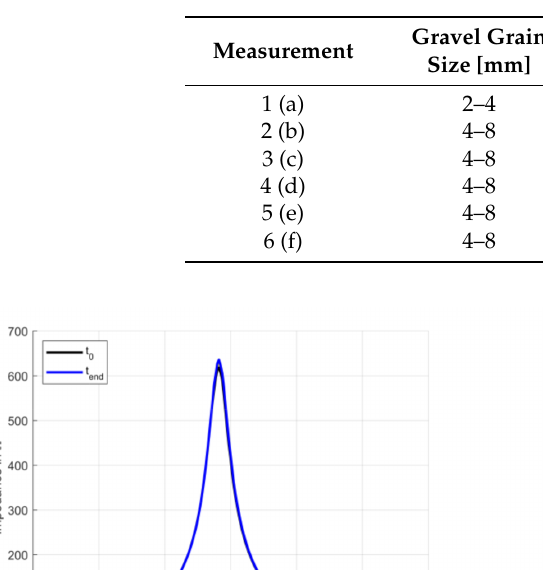
Table 2. Input parameters (gravel grain size, hydraulic gradient) and results (volume change, impedance change).